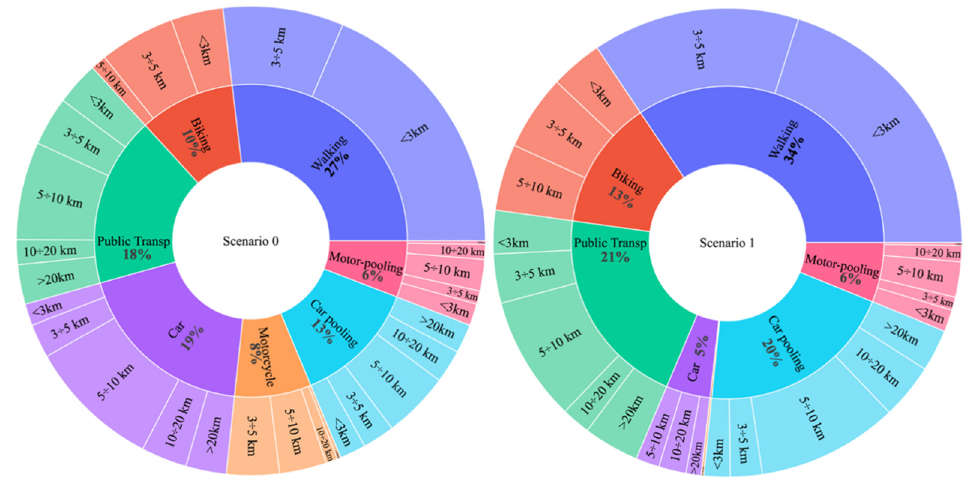
Figure 4. Percentages breakdown of the mobility means in the ex-ante (0) and improved ex-post (1) scenarios by origin distances, in reference to the total number (25,000) of commuters.